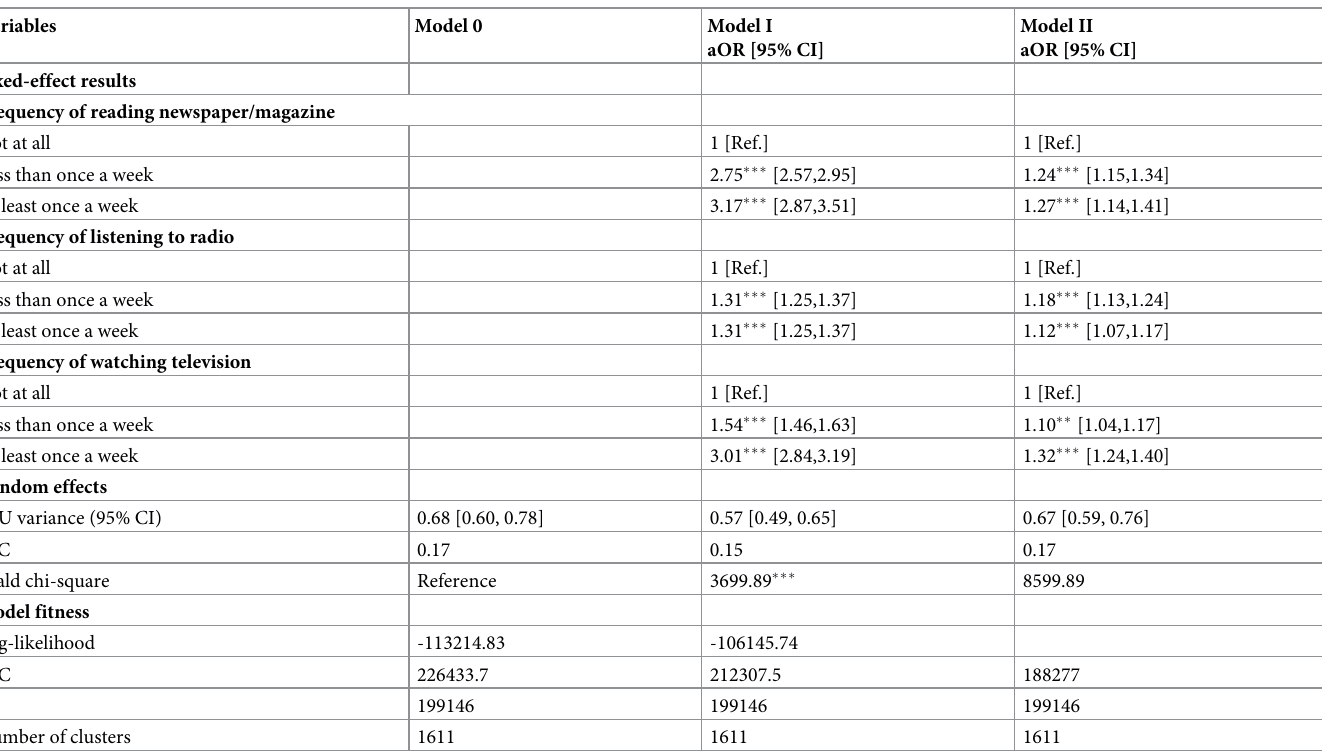
Table 4. Fixed and random effect results of the association between mass media and